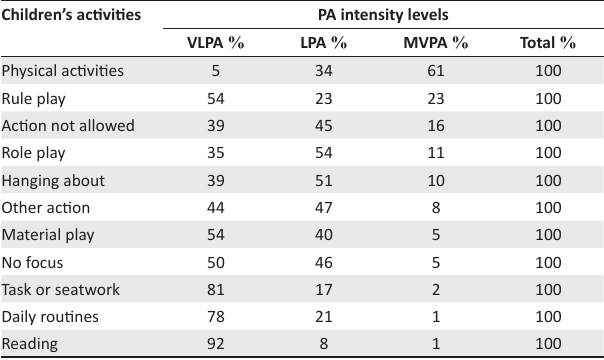
TABLE 2: Proportions of the physical activity intensity levels in children’s activities ( N = 57 881). Children’s activities